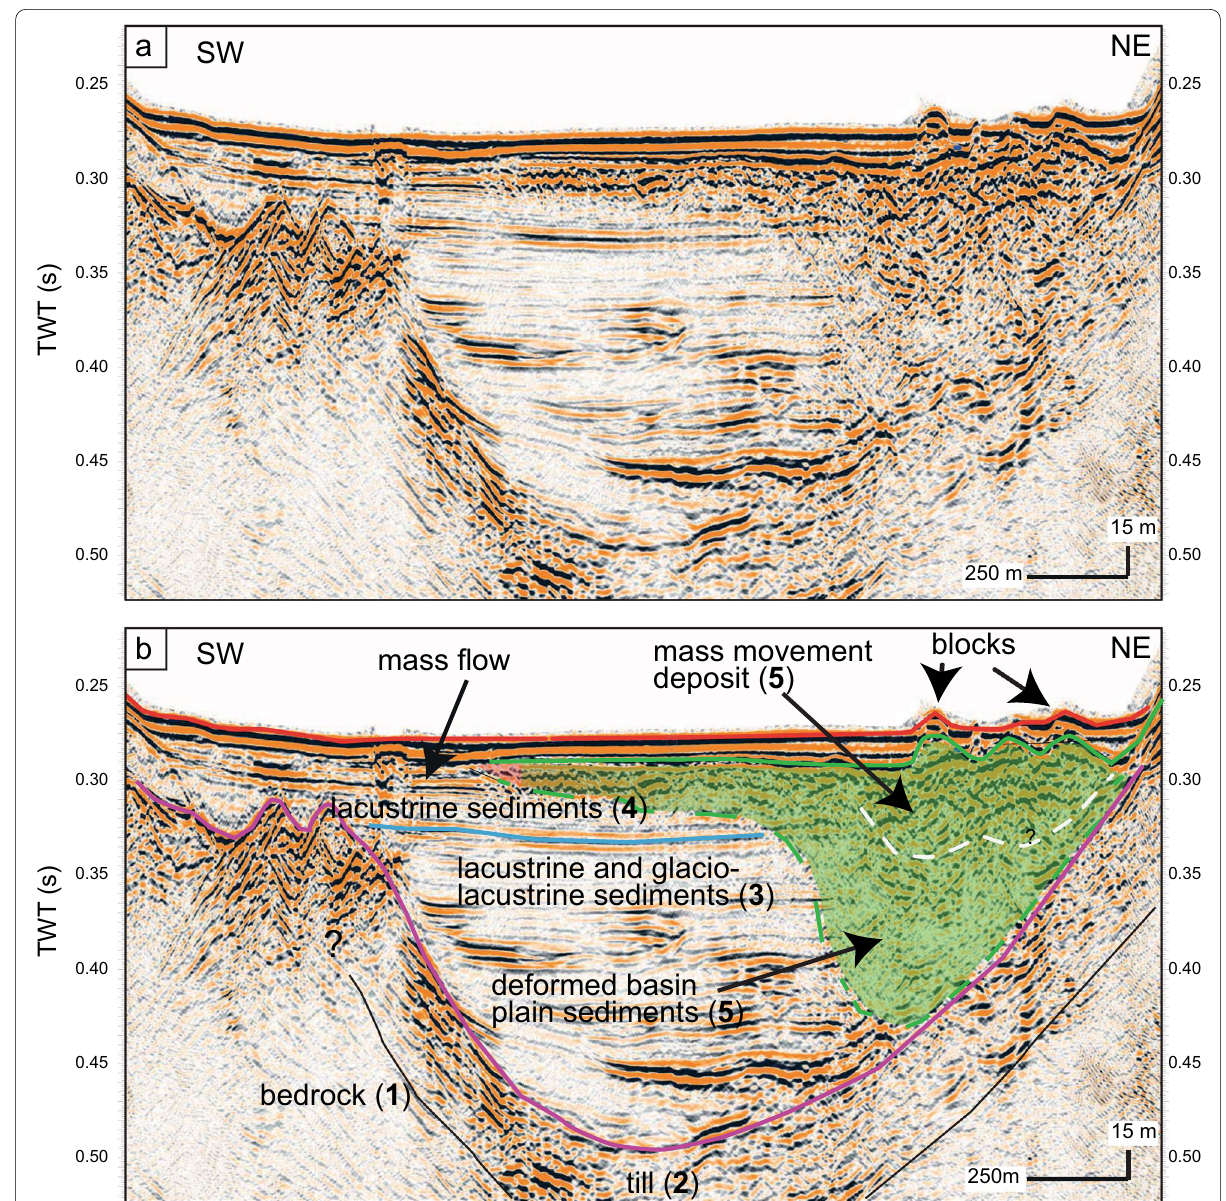
Fig. 3 Uninterpreted ( b ) and interpreted ( b ) SW-NE airgun reflection seismic profile (the geological units have been interpreted by Fabbri et al., 2017) (for position of profile see Fig. 1a). The numbers in a refer to the seismic facies described in the text. The inherited positive relief is